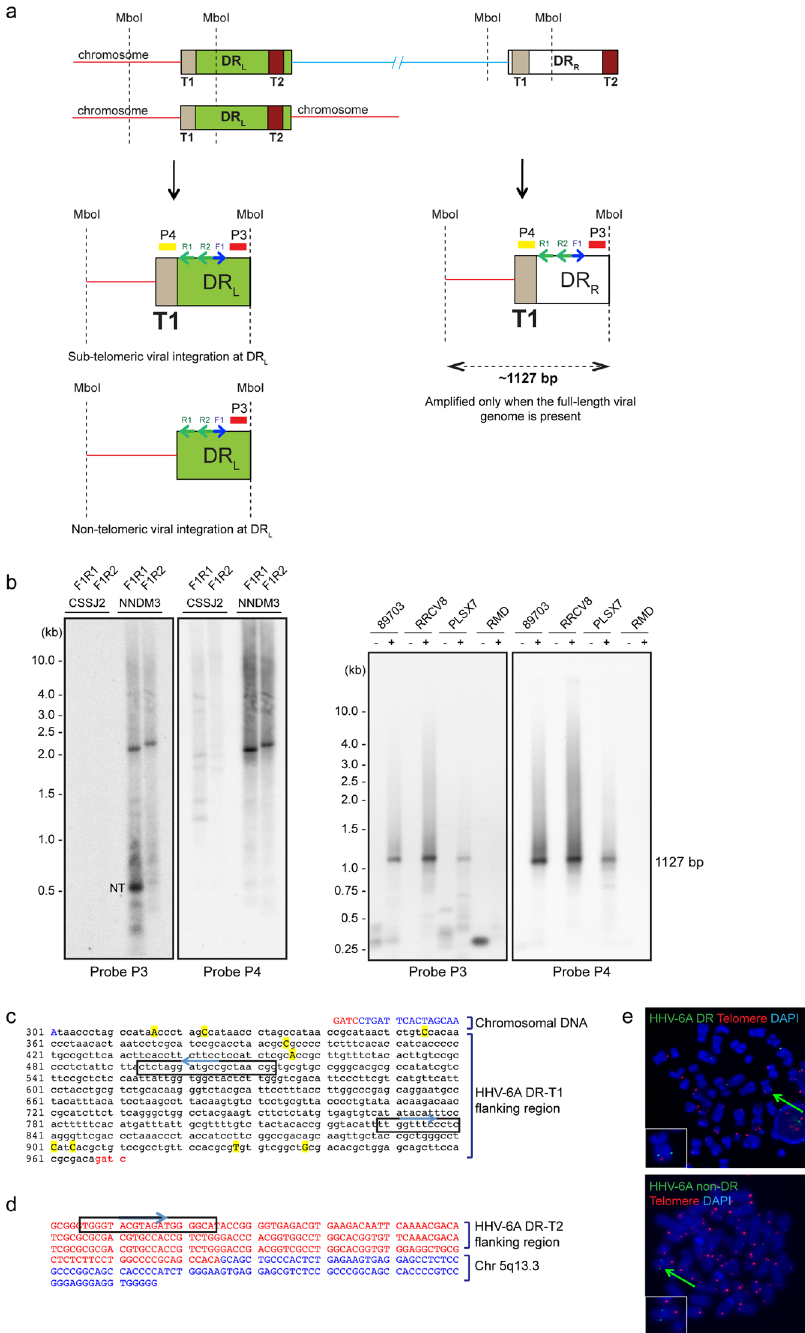
Figure 5. iPCR identified non-telomeric chromosomal integration of HHV-6A in iciHHV-6 individuals. ( a ) Schematic representation of iPCR to amplify DR-T1 junction site. Different combinations of iPCR products expected are described depending upon the structure and integration status of the viral genome. Locations of the 2 hybridisation probes (P3 and P4) are marked. F1, forward primer; R1 and R2, two reverse primers. ( b ) iPCR products from 4 different iciHHV-6A individuals (NNDM3, PLSX7, RRCV8 and 89703), a iciHHV-6B individual (CSSJ2) and non-HHV-6 control (RMD) were analysed by Southern hybridisation using two different probes. ~1.1 kb amplimer is expected from a full-length viral genome irrespective of integration status. CSSJ2 was used as a negative control to check primer specificity. NT, possible non-telomeric integration. ( c ) Sequence analysis of non-telomeric junction site at HHV-6A DR-T1 in sample NNDM3. ( d ) Sequence analysis of non-telomeric junction site at HHV-6A DR-T2 in sample NNDM3. Sequences within the rectangular boxes mark the primer locations. ( e ) FISH analysis using PBMCs from NNDM3 sample shows one of the non- telomeric integration sites. Both DR specific probe as well as a non-DR probe was used for HHV-6 detection. Arrowhead indicates integrated viral genome, which is also shown as a zoomed image on lower left hand corner of the